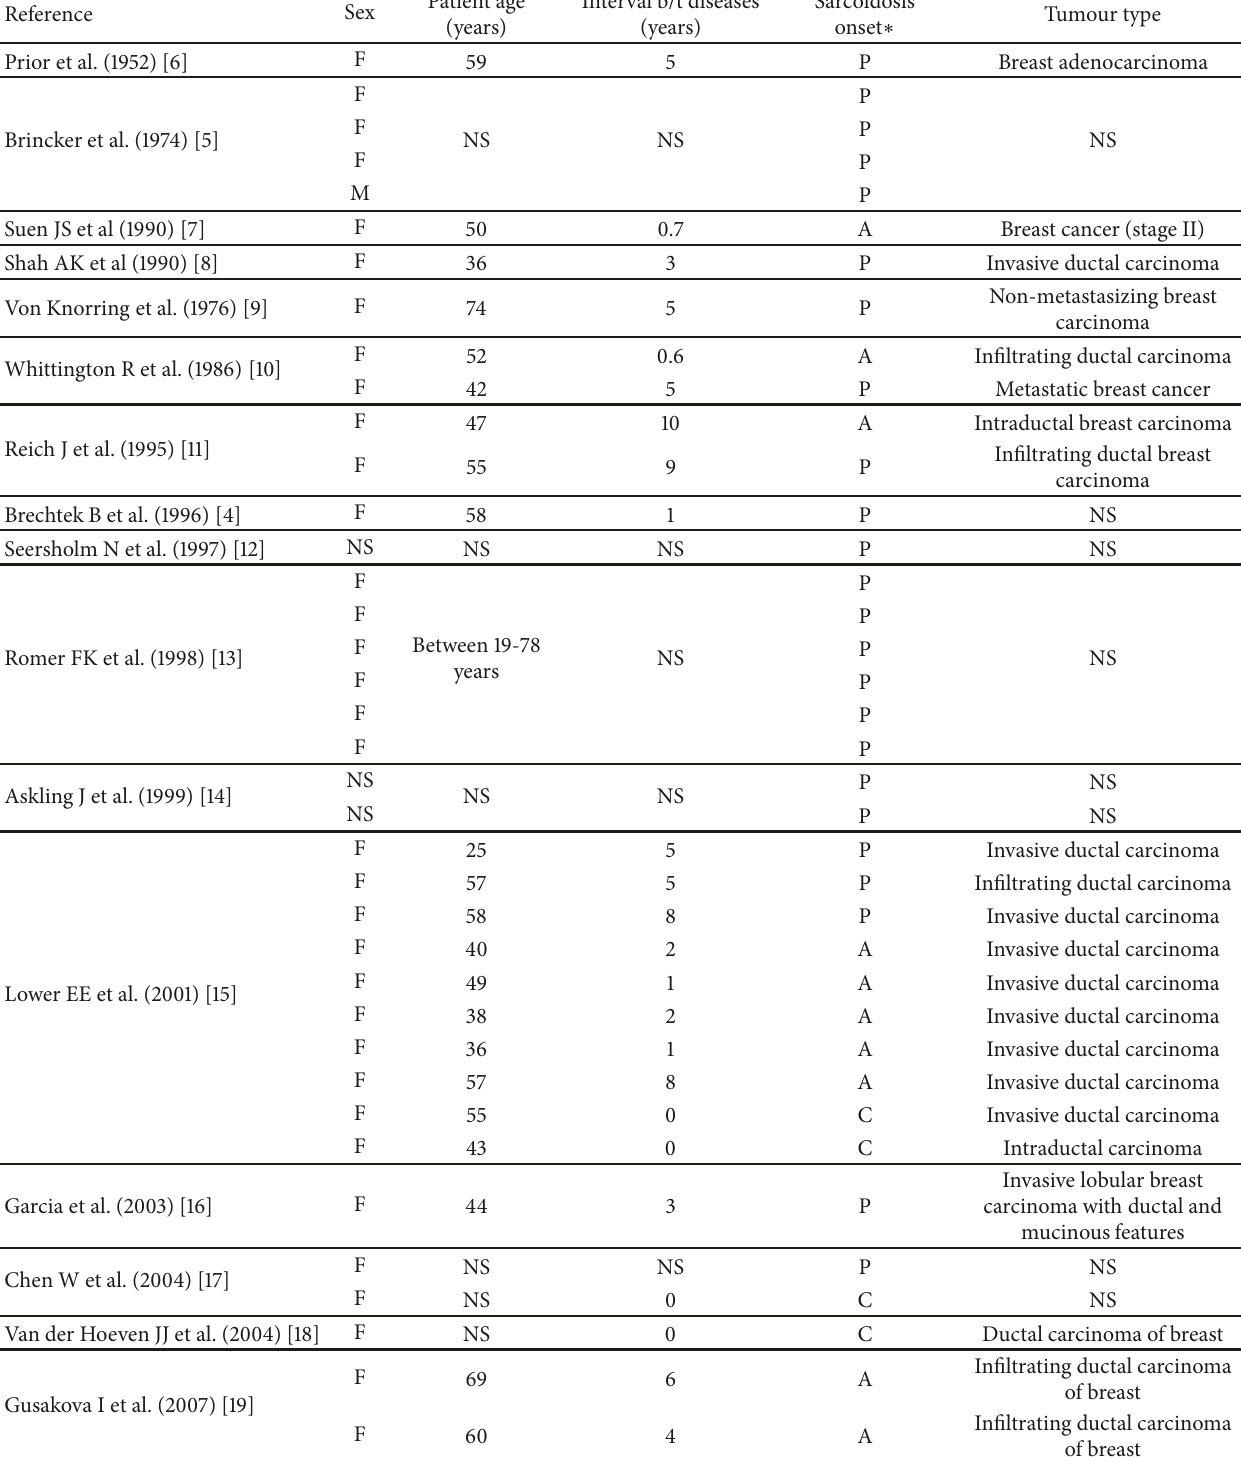
Table 1: Previous literature cases of breast cancer and